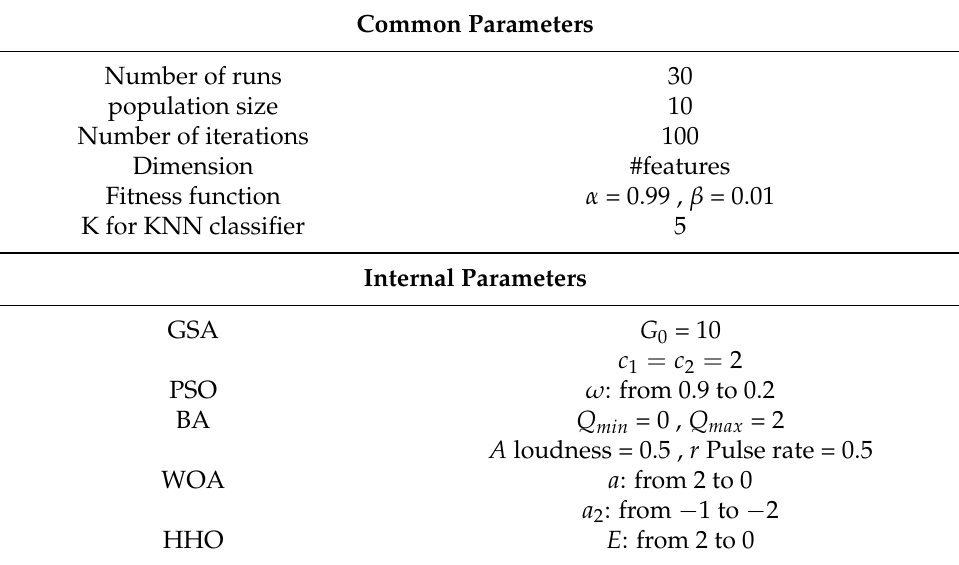
Table 3. Common and internal parameters used in the